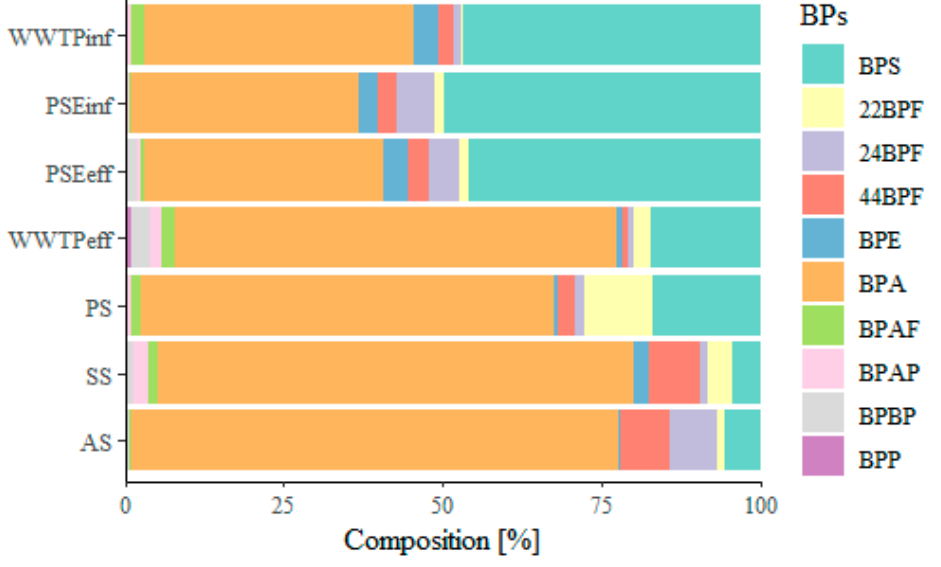
Figure 6. Composition of BPs in the selected wastewater flows and sludge.